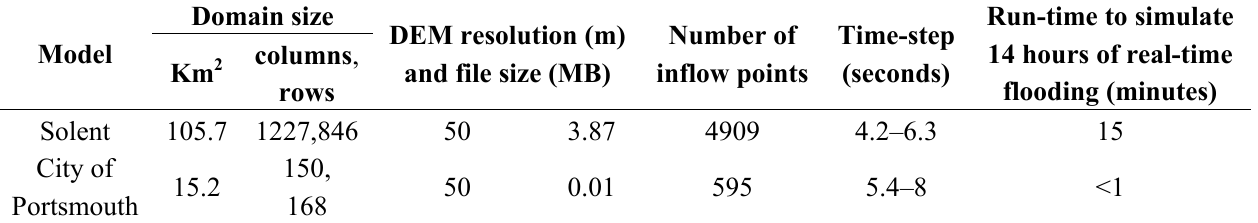
Table 2. Summary of the model scale and run-time (for a standard 2.5 GHz desktop